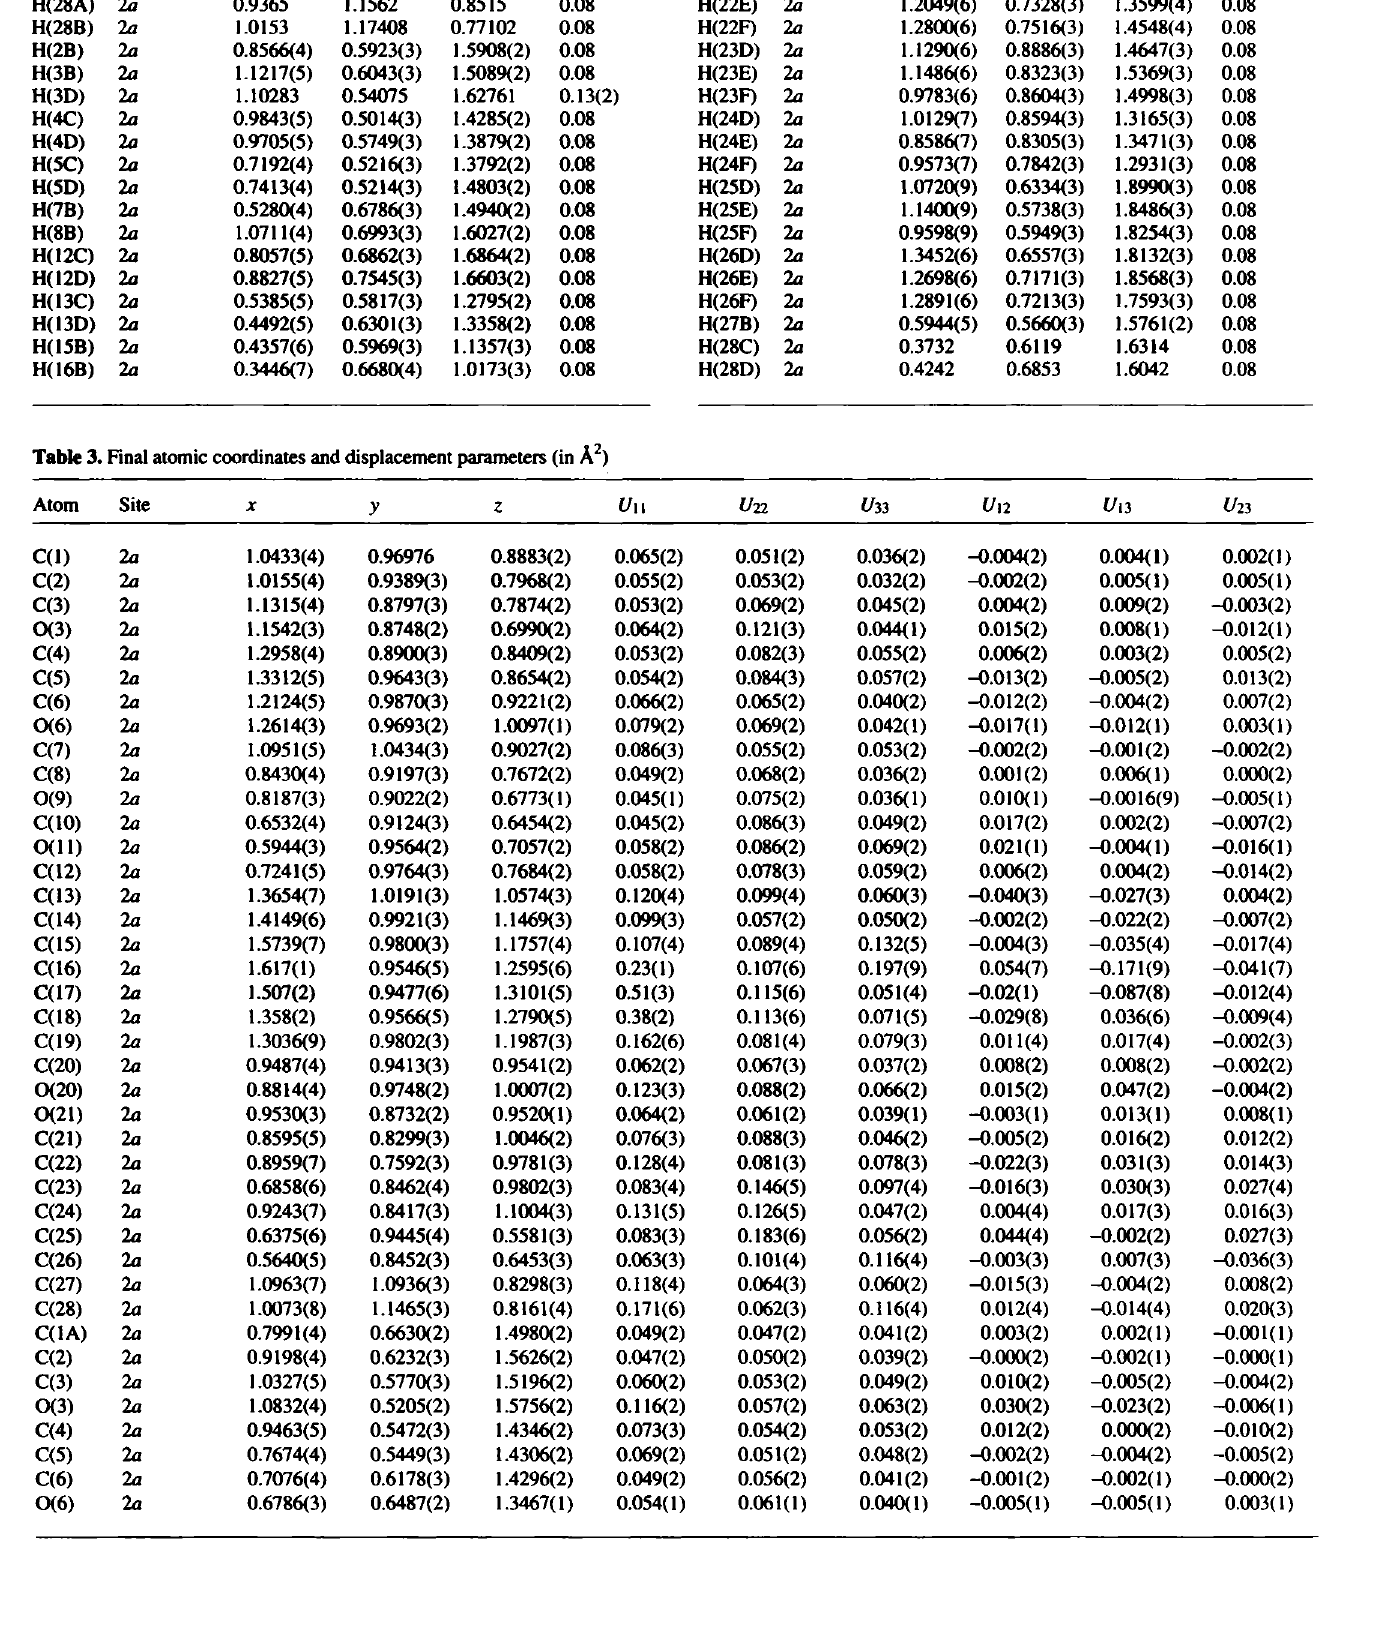
Table 3. Final atomic coordinates and displacement parameters (in Â 2